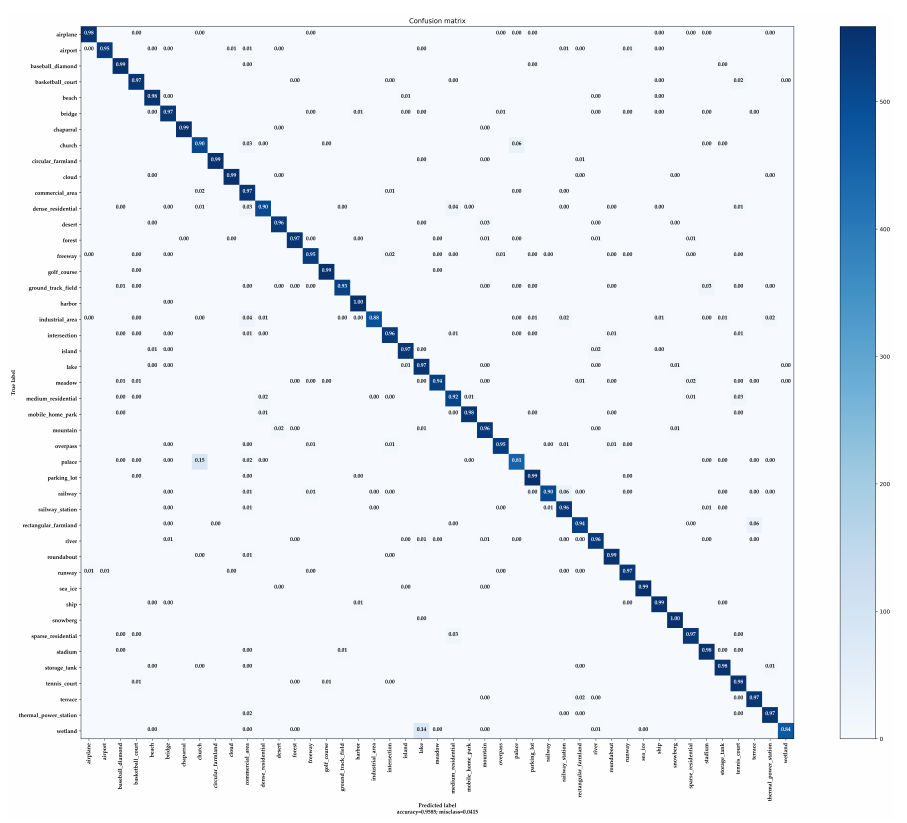
Figure 9. Confusion matrix of our P 2 FEViT (ViT-B/EffcientB0) on NWPU-R45 (train:test =